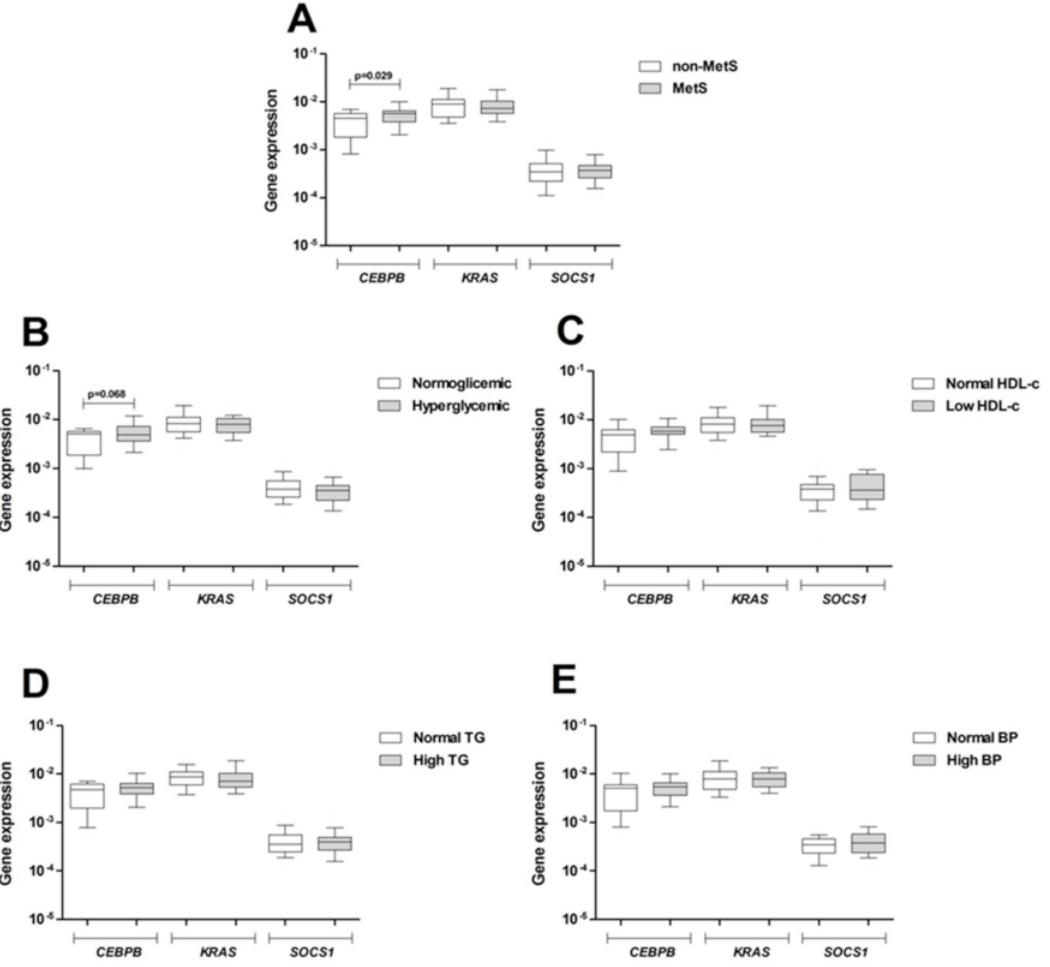
Figure 4. CEBPB , KRAS and SOCS1 mRNA expression of in peripheral blood of obese patients ( n = 80). Patients were grouped according to the MetS status ( A ) and according to the IDF criteria for MetS diagnosis: ( B ) Hyperglycemia; ( C ) low HDL-c; ( D ) high TG; and ( E ) high BP. Data are shown as box plots and were compared by Mann–Whitney U test. MetS: Metabolic syndrome; BP: Blood pressure; HDL-c: High-density lipoprotein cholesterol; TG: